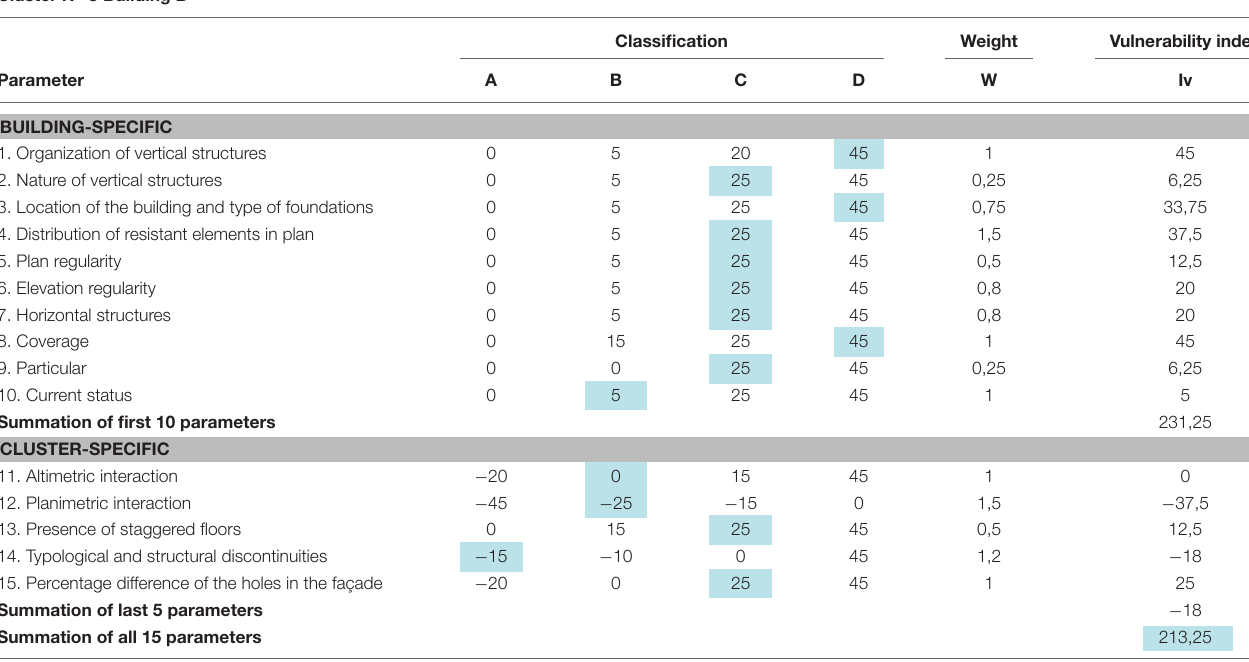
TABLE 1 | Quick form based vulnerability index of the S.U. type